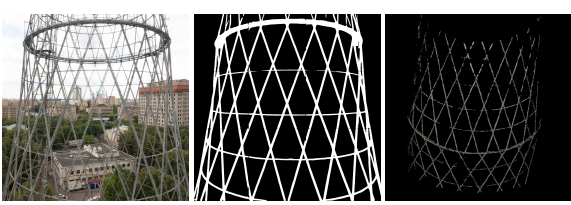
Figure 6. Results for the proposed WireNet model. An input image (left), the predicted semantic segmentation (middle) and dense point cloud generated using the created masks (right).